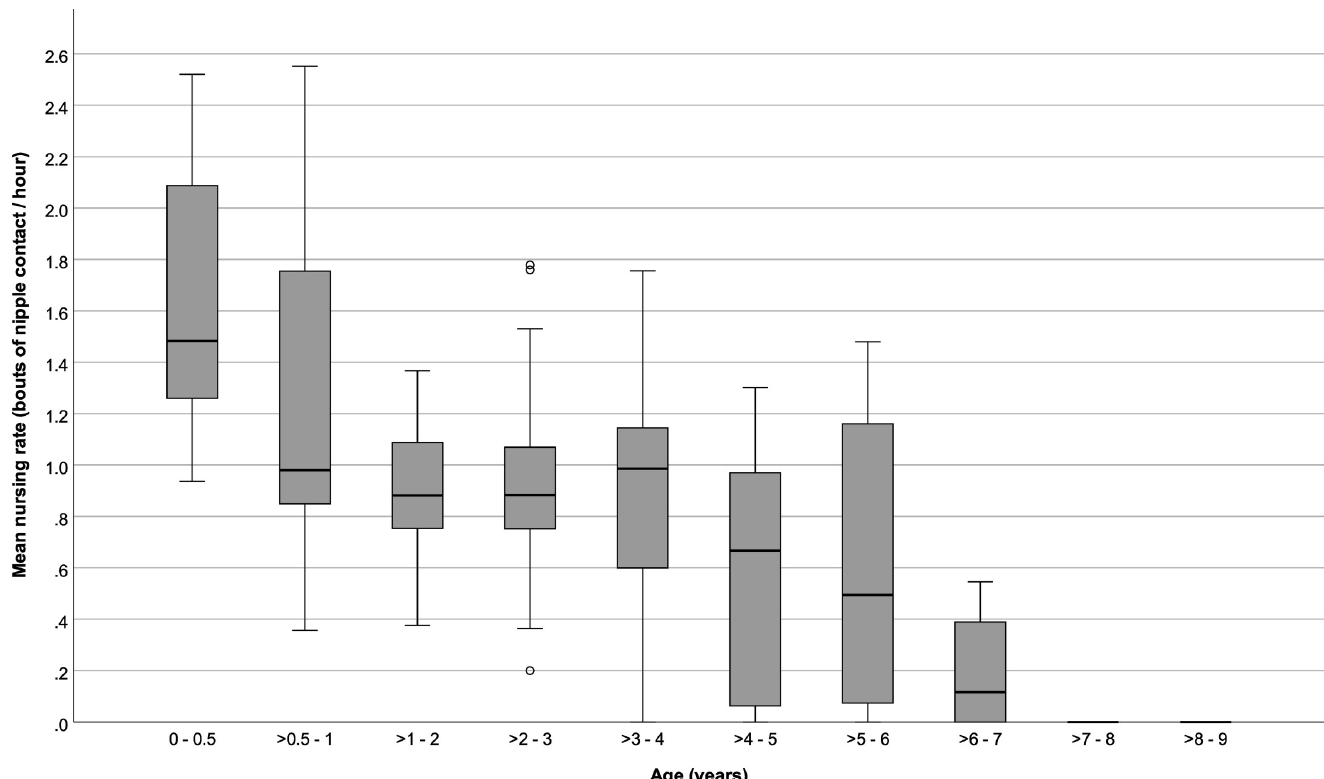
Fig 2. Average nursing rates of immature chimpanzees at different ages. Box plots show median values (solid horizontal lines), 25 th and 75 th percentile values (box boundaries), highest and lowest values (whiskers) and outliers (circles).